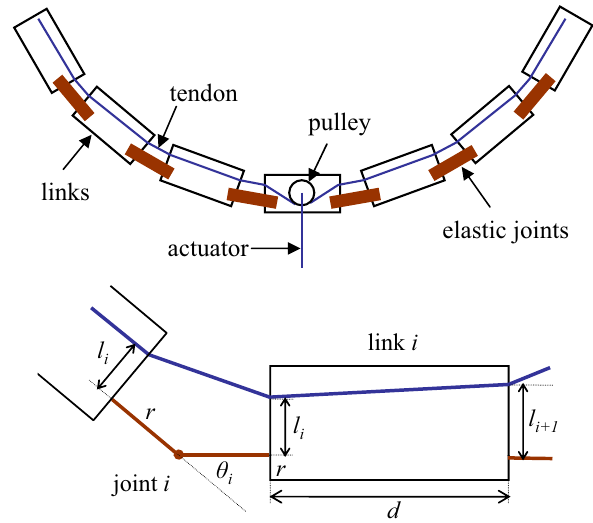
Fig. 4. OVERVIEW AND DETAILED JOINT DESCRIPTION Figure 4. Overview and detailed joint description for two-fingered gripper used as optimization case FOR TWO-FINGERED GRIPPER USED AS OPTIMIZATION CASE STUDY.